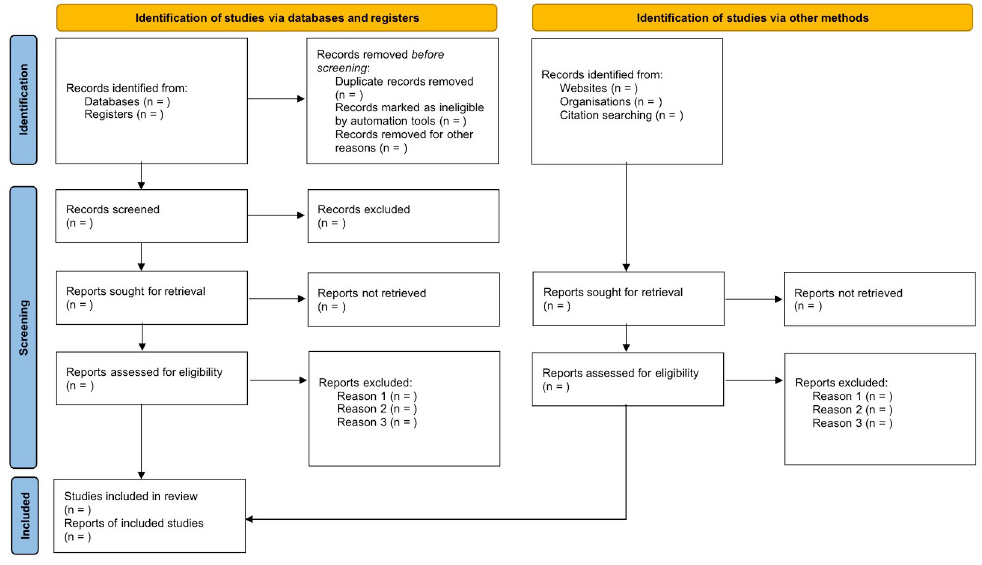
Fig 1. PRISMA flowchart of studies